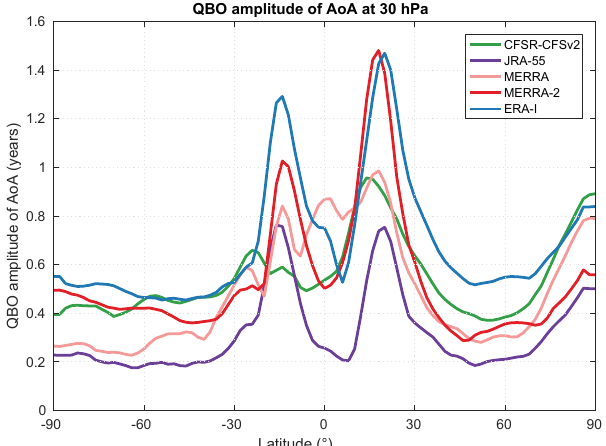
Figure 10. Amplitude (in years) of the QBO variation in the 2002– 2015 linear regression fit of AoA, as a function of latitude at pres- sure 30hPa. Same color codes as in previous